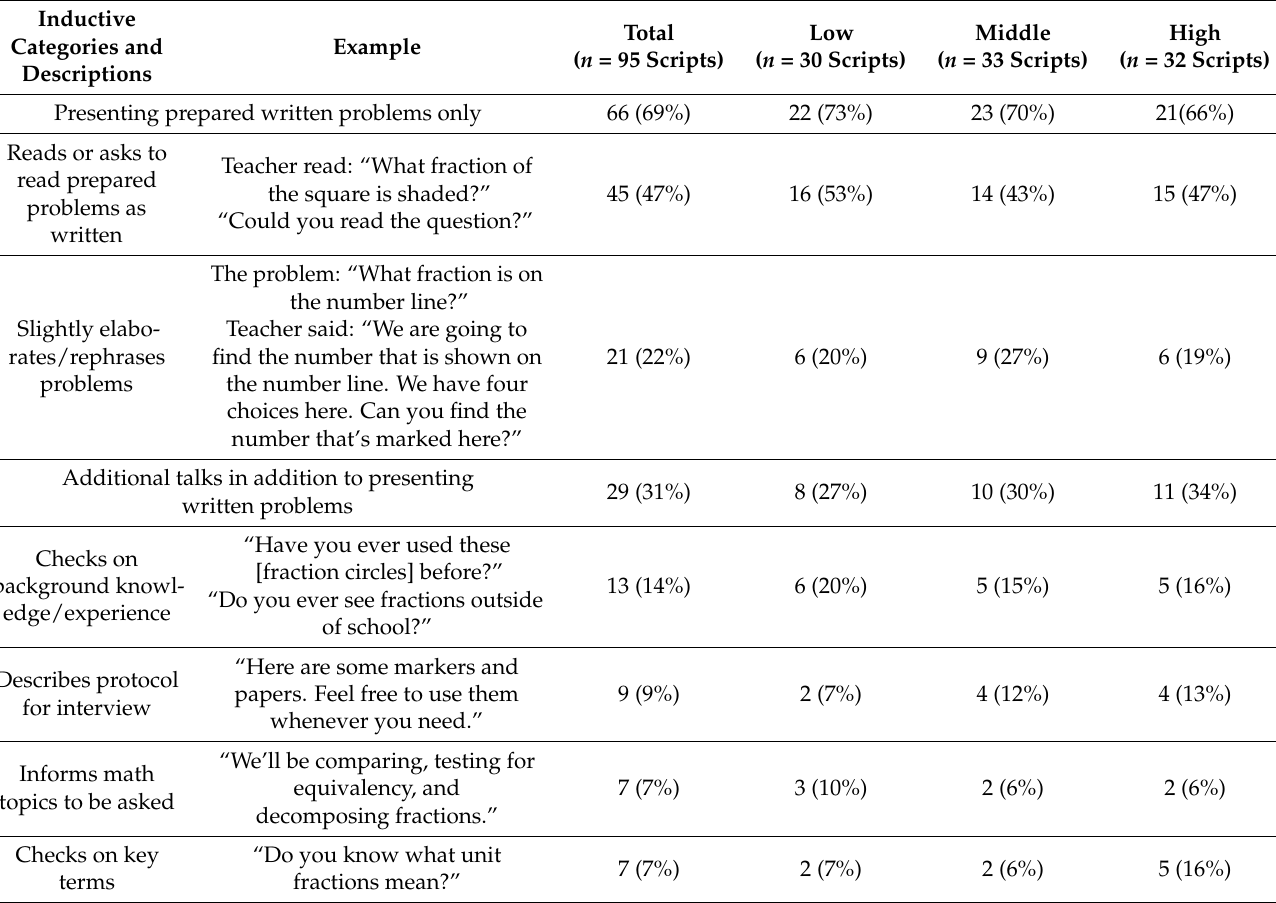
Table 4. Inductive categories and descriptions of teacher talking during